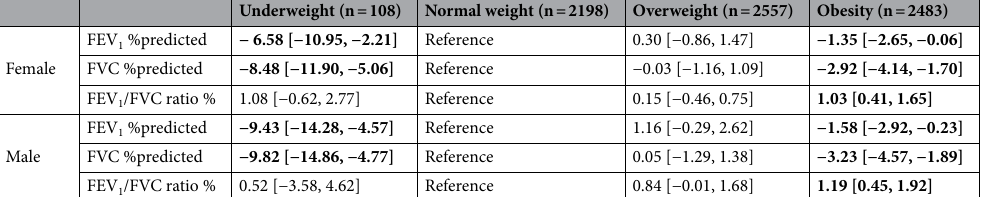
Table 2. Association of body weight and pulmonary function. Data were weighted estimates and expressed as mean [95% confidence interval]. Multiple linear regression was adjusted for age, race, education level, physical activity (MET score), smoking status. Bold: p <